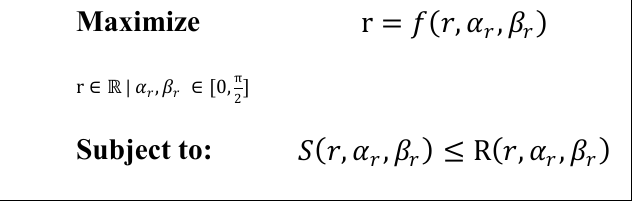
Figure 2: Subroutine for Problem